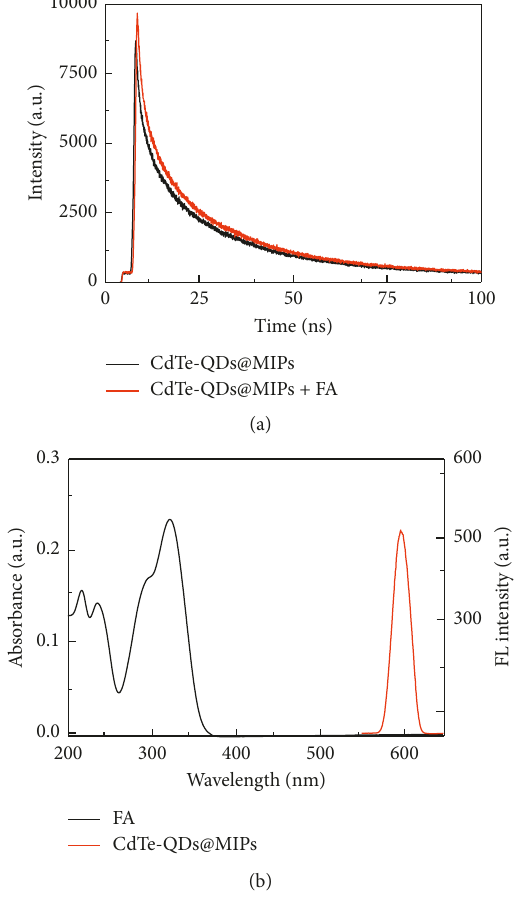
Figure 5: Fluorescence lifetime spectra of CdTe-QDs@MIPs in the absence and presence of FA (a) and UV-vis absorption spectrum of FA and fluorescence emission spectrum of CdTe-QDs@MIPs The influence of incubation time of CdTe-QDs@MIPs with FA was important for the complete binding. As presented in Figure 6(c), quenching efficiency of CdTe-QDs@MIPs